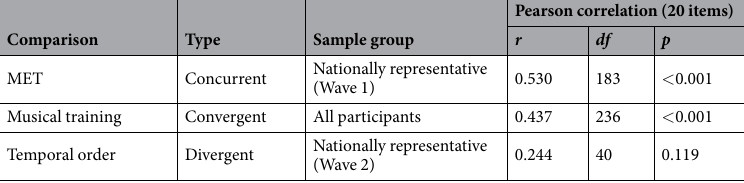
Table 3. Results of nomothetic span comparisons for test Version